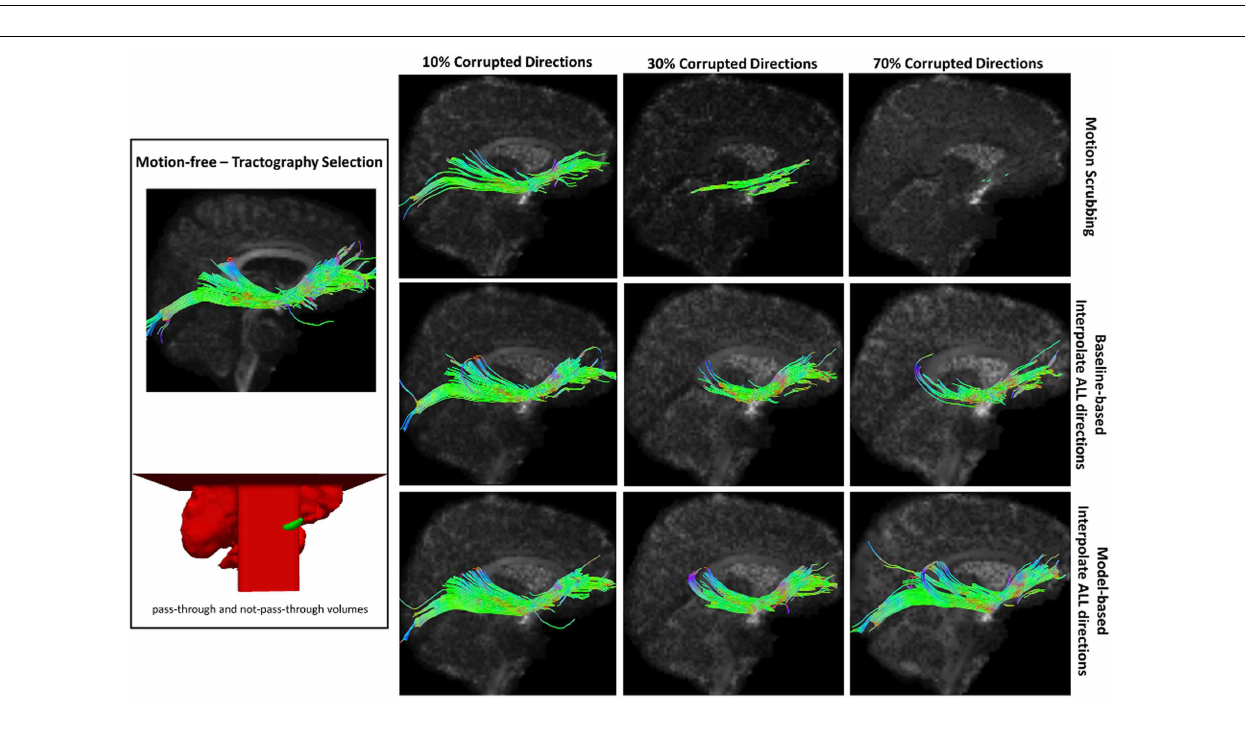
baseline and model-based reference volumes). Note that motion scrubbing cannot recover long tracts such as IFO beyond 10% motion corruption. Further, motion-based motion correction tends to recover longer tracts at high motion corruption compared to baseline-based